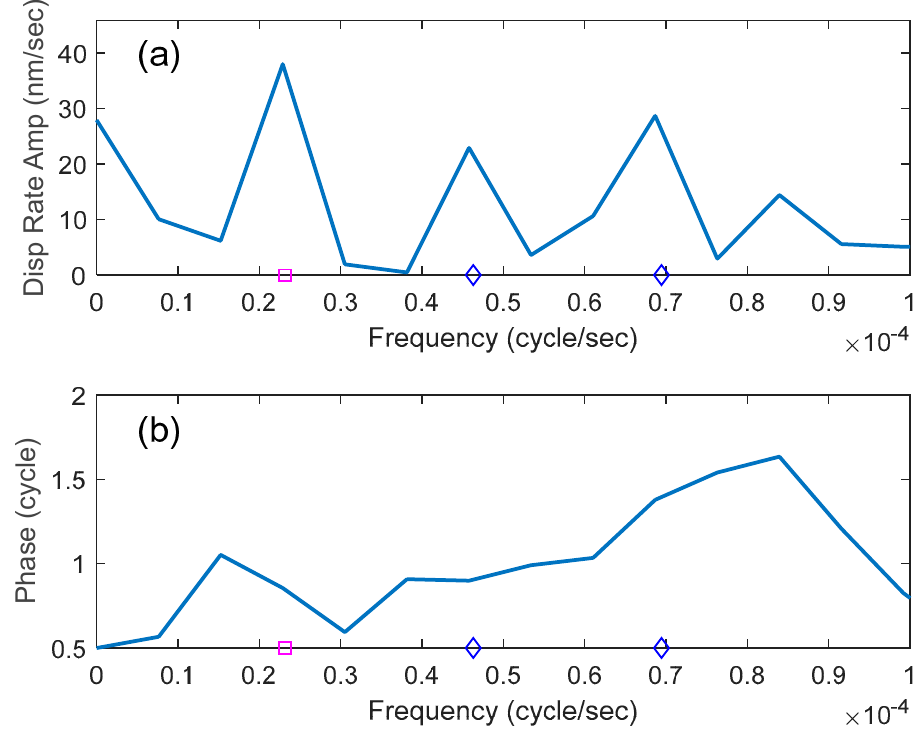
Figure 2. Fast Fourier Transform spectra of mean displacement of 160 channels (360–519). The pink square represents a frequency corresponding to a 12-hour period, and the blue diamonds indicate multiple frequencies corresponding to 6 and 4 hour periods, respectively, ( a ) amplitude spectrum, ( b ) phase spectrum.